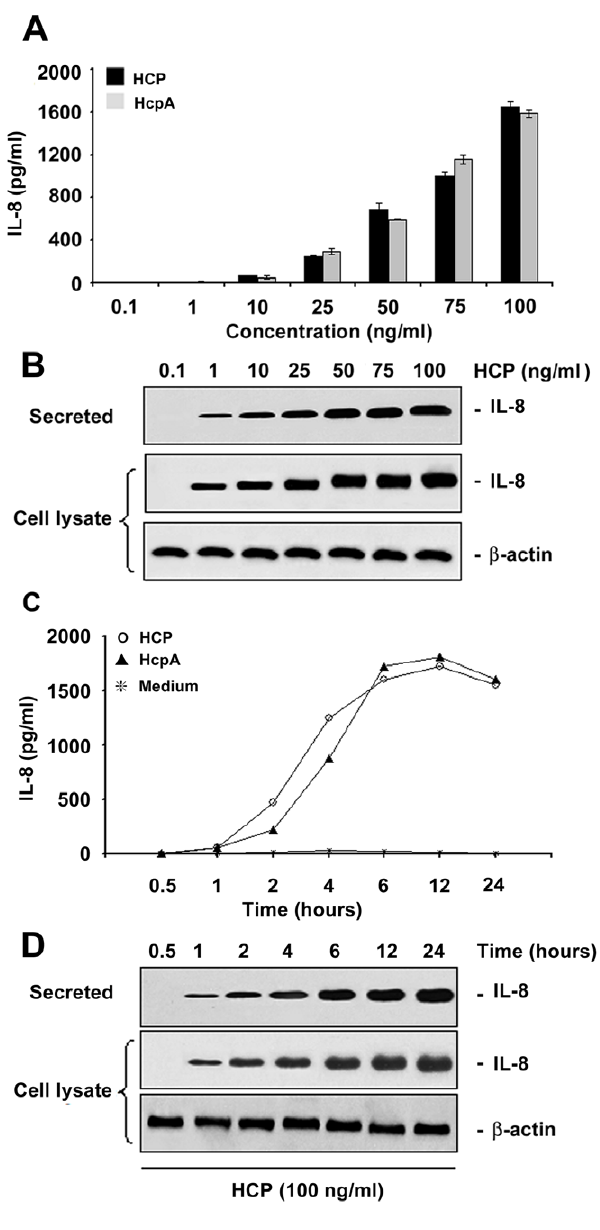
Figure 5. Induction of TNF- a release by purified HCP. An ELISA- based assay demonstrating the induction of TNF- a in polarized HT-29 cells in response to different concentrations of purified HCP and HcpA (A). Western blot showing the kinetics of secreted proteins and cell lysates produced after the incubation of polarized HT-29 cells with HCP and HcpA (B). Both proteins stimulate the production of TNF- a in HT-29 cells in a dose-dependent manner. Purified HCP (100 pg/ml) and HcpA (100 pg/ml) were incubated with polarized HT-29 cells at different intervals (C). The supernatant recovered from the basolateral surface showed a significant time-dependent increase of TNF- a as shown by Western blotting (D). Detection of actin was used as a protein loading control.